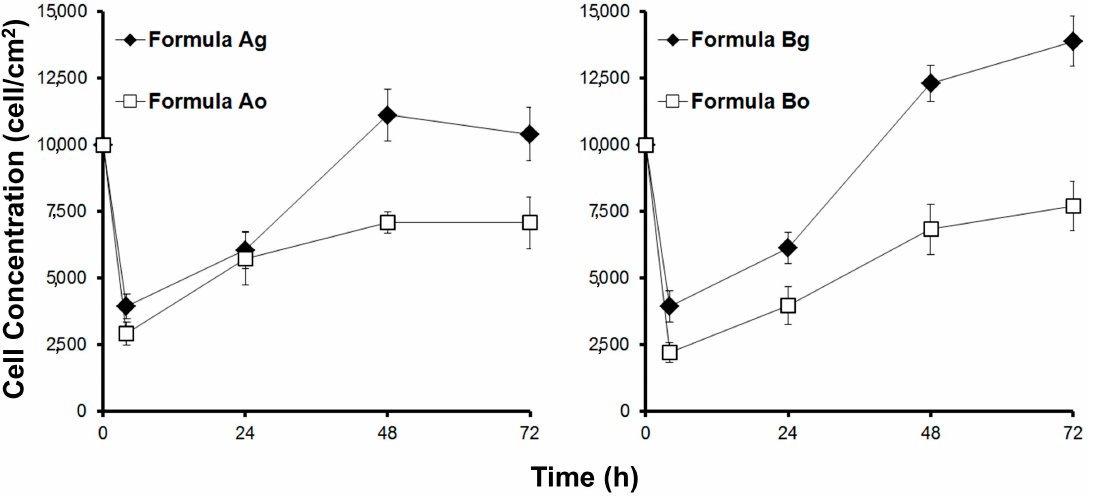
Figure 4. Cell growth of myoblasts seeded onto scaffolds (scaffold thickness ~3 mm).